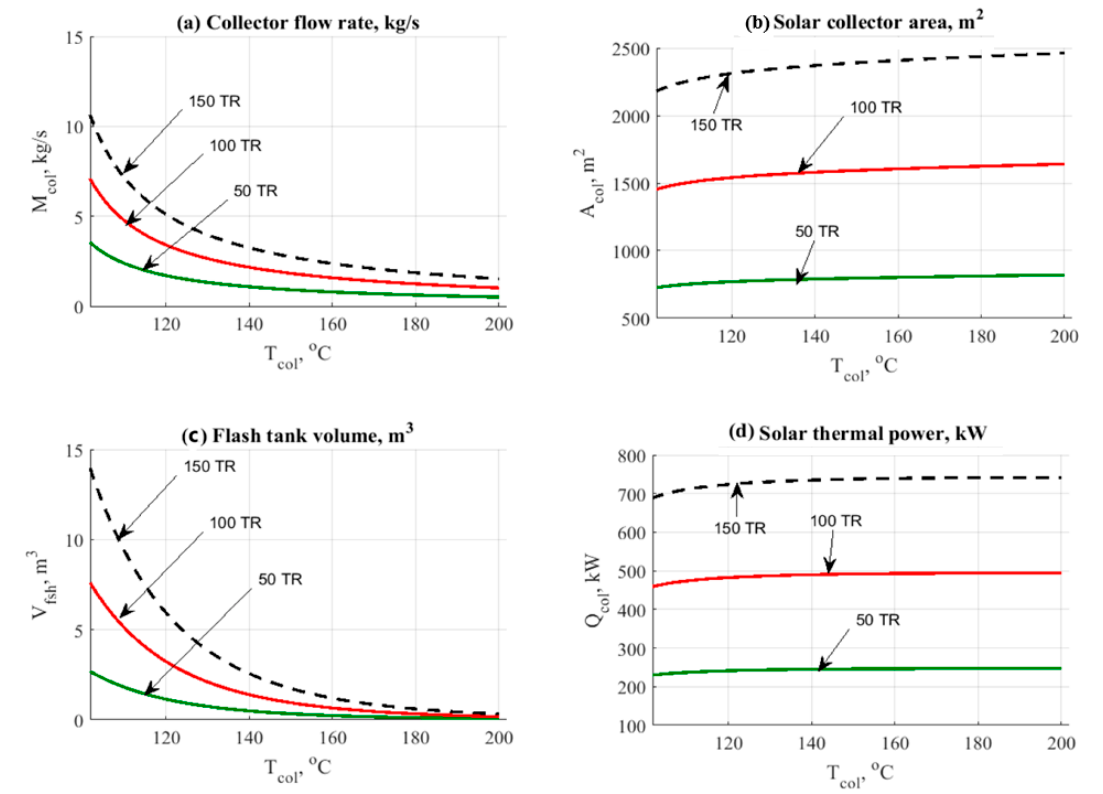
Figure 2. Data results for ETC/H2O ‐ LiBr cycle vs. variation in exit upper temperature of the solar field. ( a ) Collector flow rate. ( b ) Solar collector area. ( c ) Flash tank volume. ( d ) Solar thermal power.